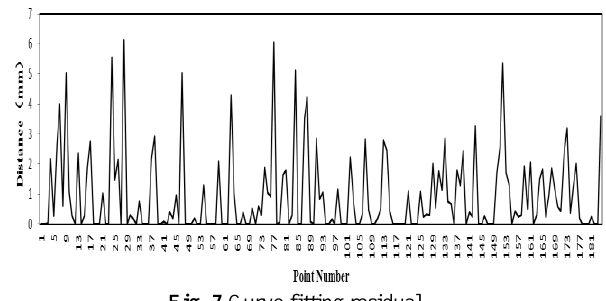
Fig. 7 Curve fitting residual